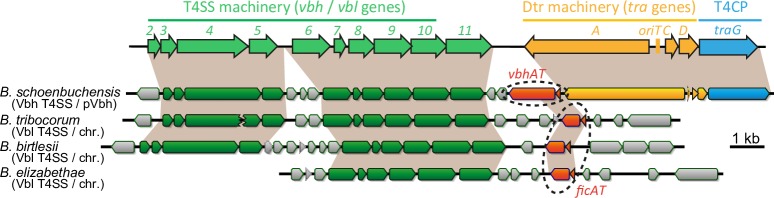
BtrFicTA and related FicTA modules are encoded with deteriorated conjugative T4SS machineries.Loci encoding bacterial conjugation systems consist of genes for the T4SS machinery (green), the Dtr machinery (yellow), and a type IV coupling protein (T4CP) that links these functions by recruiting the Dtr machinery to the T4SS (blue). Like VbhTA on pVbh, BtrFicTA of B. tribocorum and its orthologs are encoded directly downstream of the T4SS machineries (annotated as Vbl T4SS for “VirB-like”).